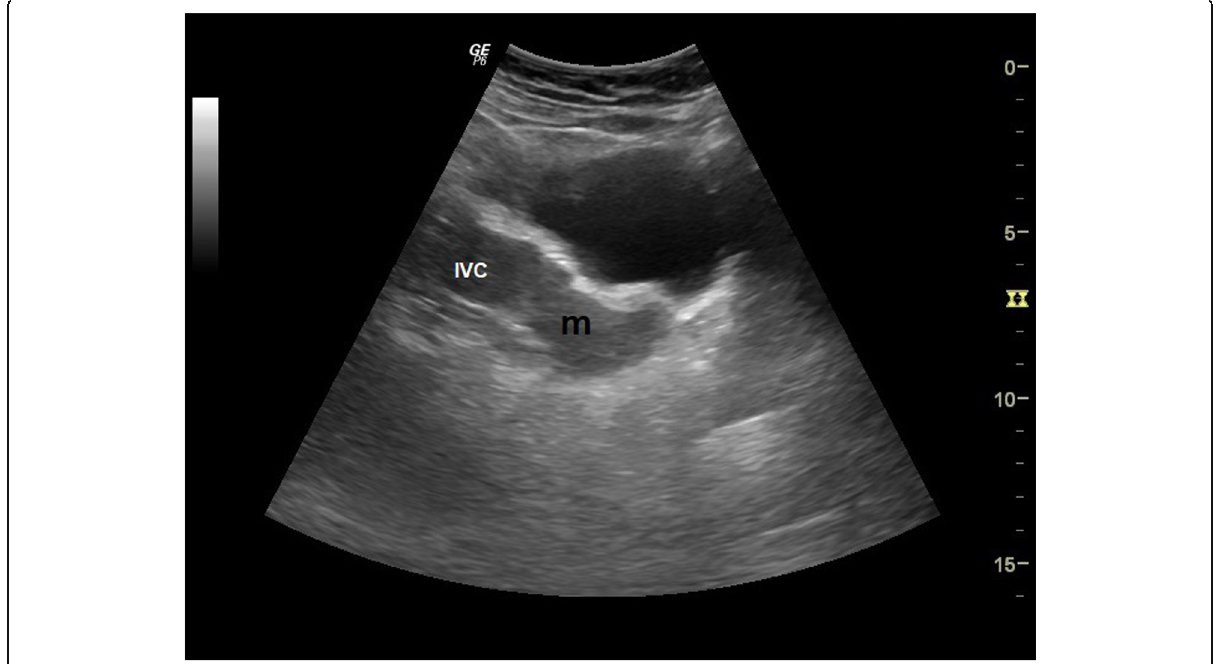
Fig. 1 Oblique grayscale ultrasound image showing the extension of intra-mural thrombus (in IVC ) into the right heart